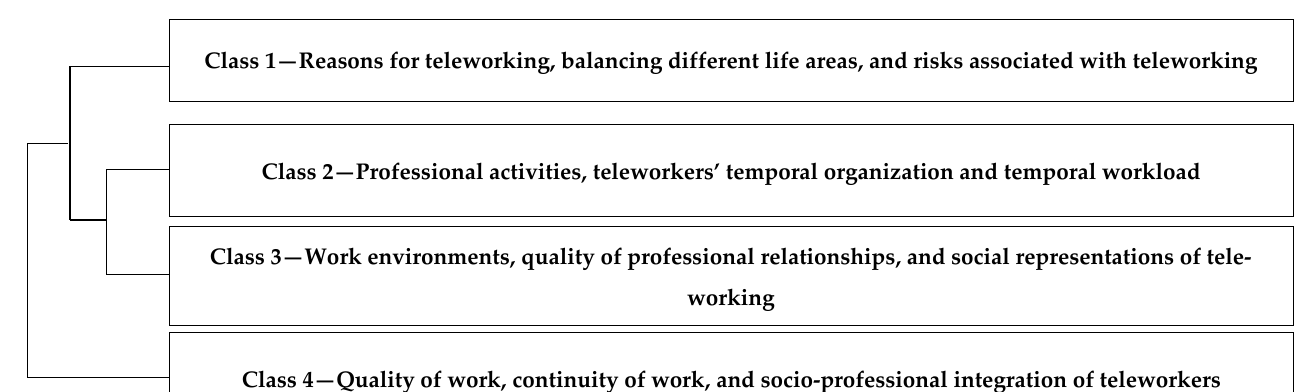
Figure 1. Dendrogram of the stable classes identified from the Descending Hierarchical Classification (DHC). Alceste uses the chi-square measurement of association to assess the extent to which the interviewee discourses, according to their attributes, is or is not associated with a particular class of vocabulary.